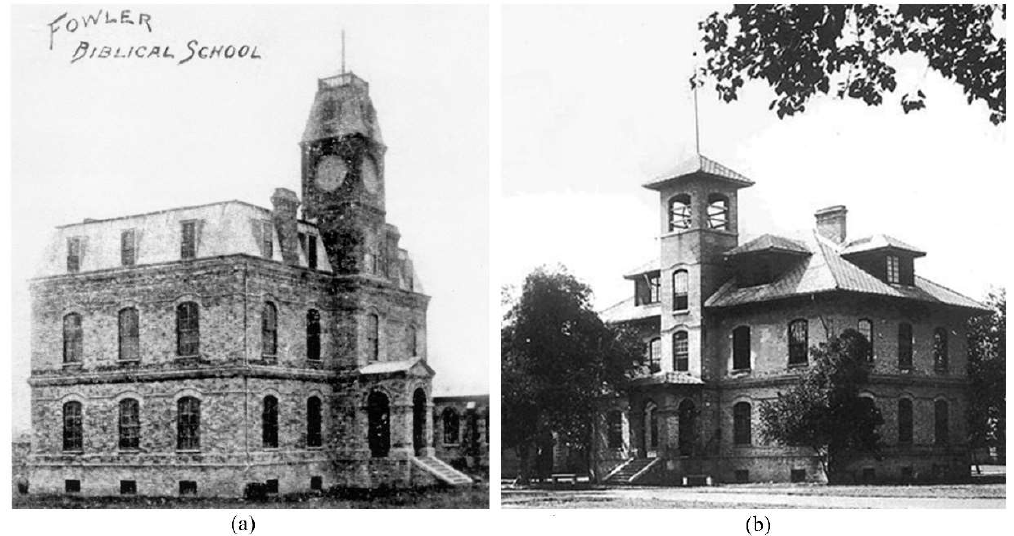
Figure 5. Historical photos of the bell tower. ( a ) It was first built in 1888. ( b ) It was rebuilt after fire in 1917 (source: [27]).